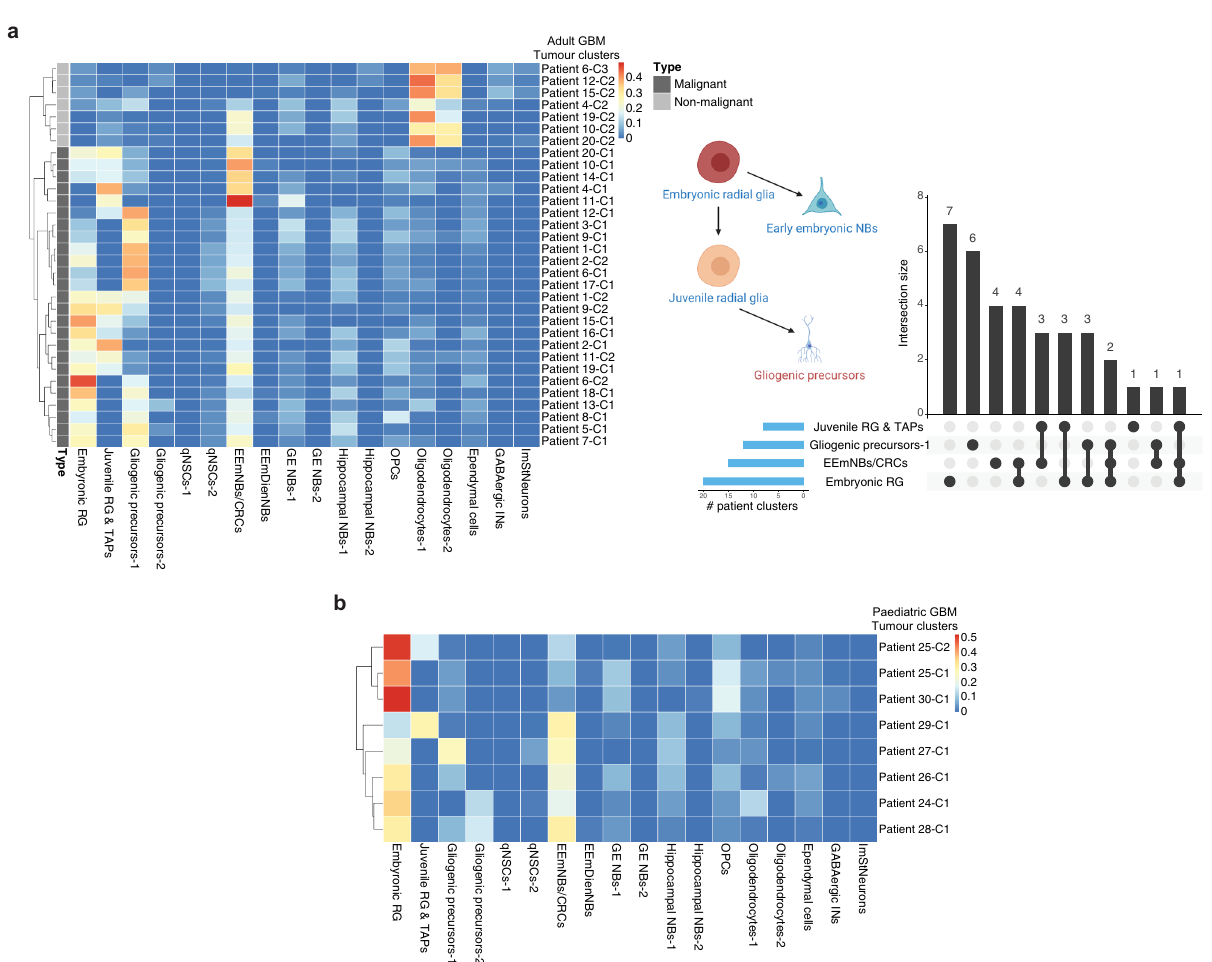
Fig. 4 Adult and paediatric human GBMs show an embryonic/juvenile-like cell signature. a Left: deconvolution analysis heatmap of malignant and non- malignant clusters from 20 adult GBM patients from Neftel et al. 2019 showing the estimated relative fraction of the mouse cell-types for each patient cluster (see Methods). The bar on the left indicates the state of the cells (malignant or non-malignant). Each patient sample was clustered separately (see patient clustering in Supplementary Fig. 5d) and the clusters are denoted as e.g., “ Patient#1-cluster#1 ” = “ Patient 1-C1 ” (see Supplementary Data 1). Shown on the right is a bar plot summarizing the matching results and overlap size between the patient clusters (e.g., 3 patient clusters matched to both embryonic RG and gliogenic precursors) and a schematic summary of the tumour lineage from the deconvolution analysis. b Deconvolution analysis heatmap of malignant clusters from 7 paediatric GBM patients from Neftel et al. 2019 (see Supplementary Data 1) showing the relative fraction of the mouse cell-types for each patient cluster. Each patient sample was clustered separately (see patient clustering in Supplementary Fig. 6a) and the clusters are denoted as e.g., “ Patient#24-cluster#1 ” = “ Patient 24-C1 ” (see Supplementary Data 1). RG Radial glia, TAPs Transient amplifying progenitors, qNSCs Quiescent neural stem cells, EEmNBs/CRCs Early embryonic neuroblasts/Cajal-Retzius cells, EEmDienNBs Early embryonic diencephalon neuroblasts, GE NBs Ganglionic eminence neuroblasts, OPCs Oligoprogenitor cells, INs Interneurons, ImStNeurons Immature striatal